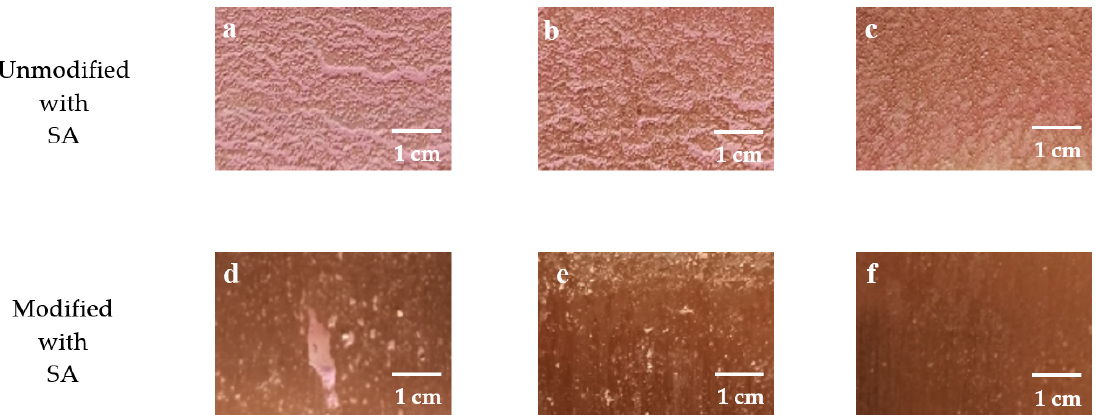
Figure 5. The self-cleaning effect diagram of the copper sheets surface. ( a , d ) Copper sheet of L 0 = 3.3 μm; ( b , e ) copper sheet of L 0 = 2.4 μm; ( c , f ) copper sheet of L 0 = 1.6 μm.